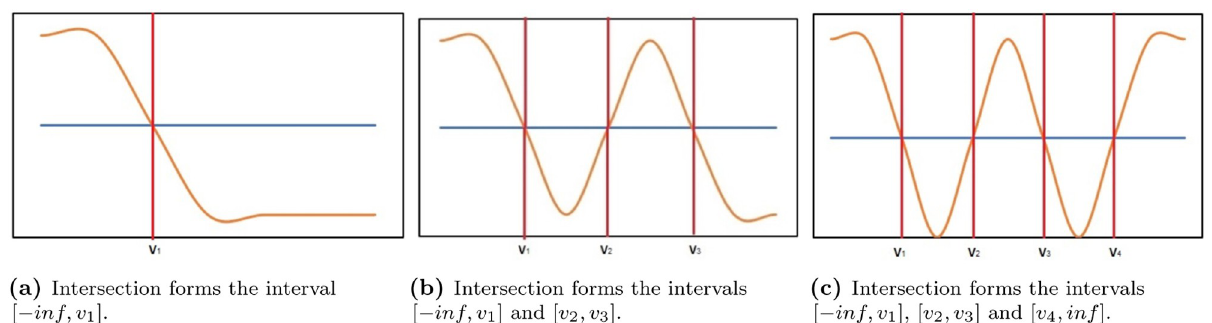
Fig 5. Special cases of the intersection between empirical distributions. The blue line represents the outcome variable, and the yellow line the pattern-conditional outcome variable. (a) Intersection forms the interval [ − inf, v1]. (b) Intersection forms the intervals [ − inf, v1] and [v2, v3]. (c) Intersection forms the intervals [ − inf, v1], [v2, v3] and [v4,